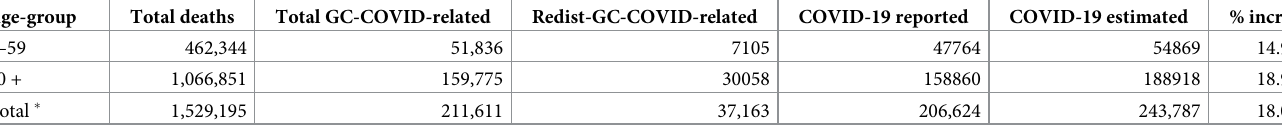
Table 4. GC-COVID-related deaths redistributed as COVID-19 cases according to age. Brazil, 2020.